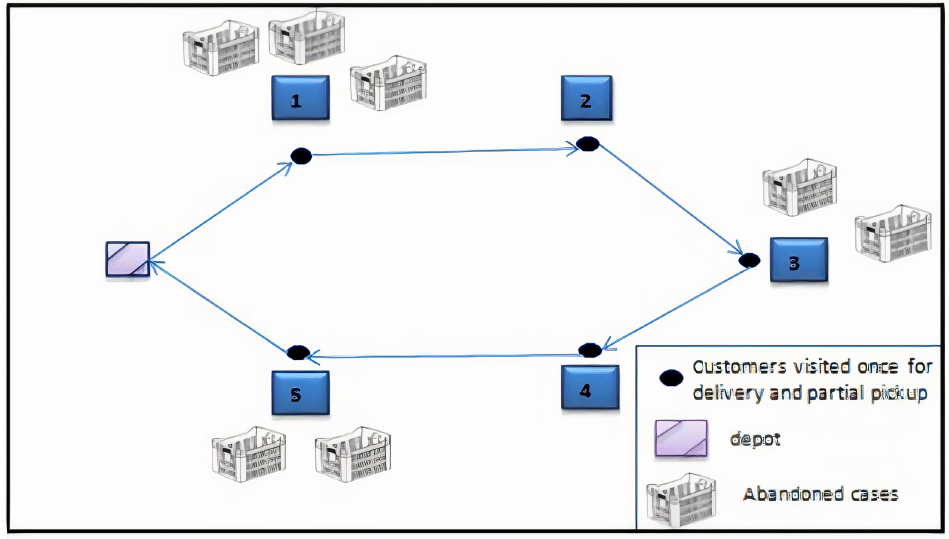
Figure 4. Overview of the flexible VRPSPD: MILP